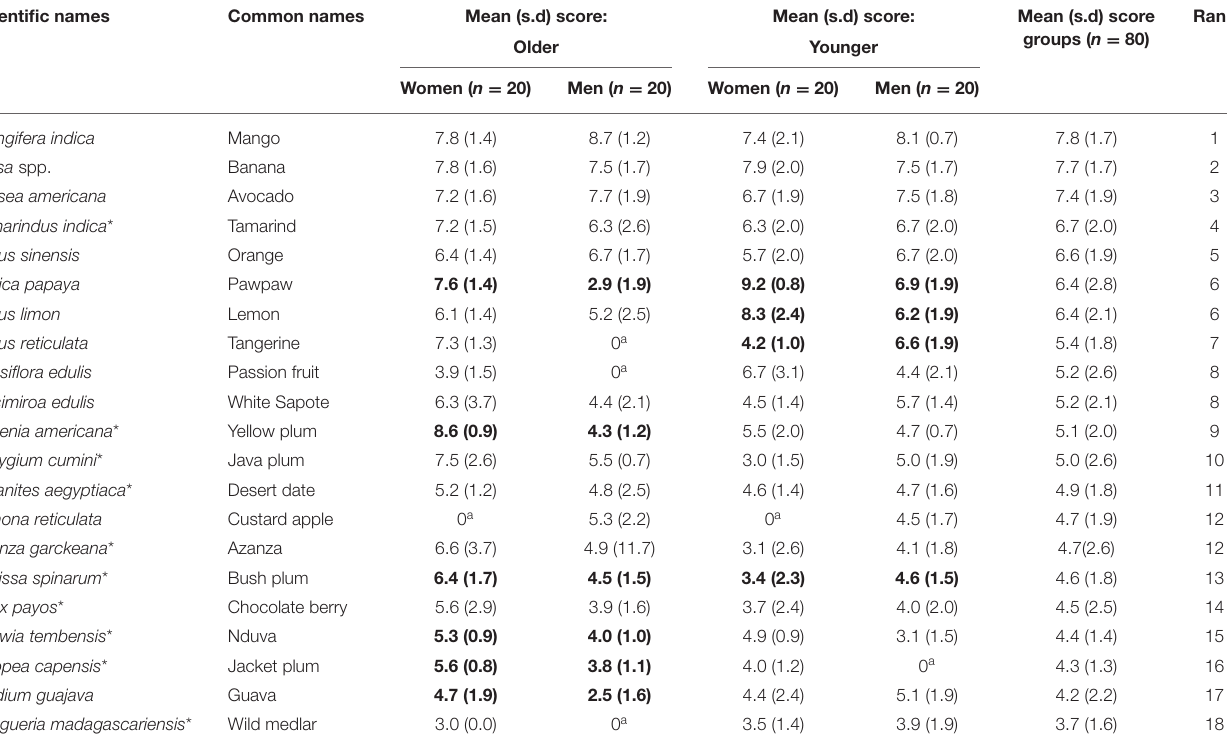
TABLE 2 | Score ranking of the 10 most preferred food trees according to different gender and age groups in both Kitui West and Mwingi West of Kenya.